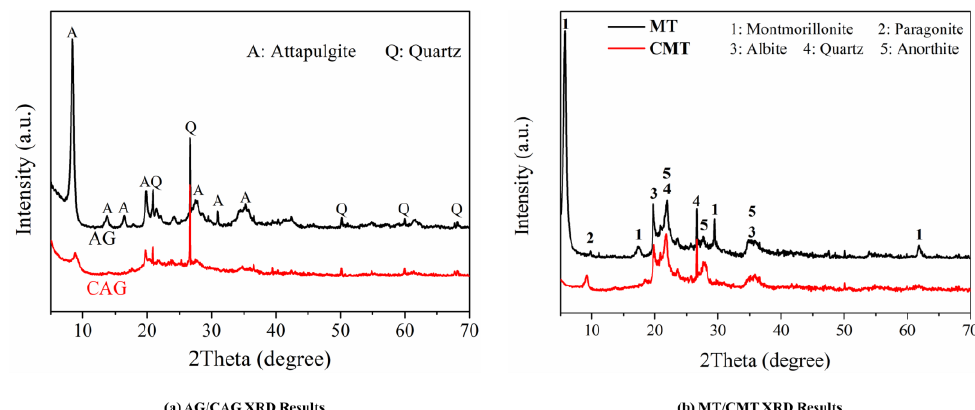
Figure 5. Phase composition analysis of clay before and after calcination: ( a ) attapulgite; ( b ) mont- morillonite.